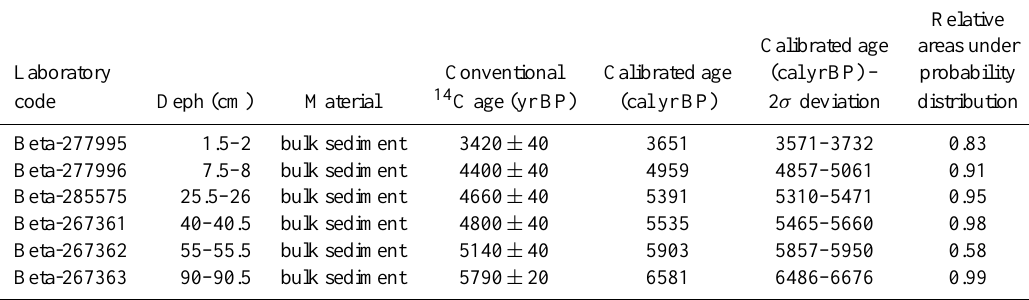
Table 1. Radiocarbon chronology of core LT1 from Lake